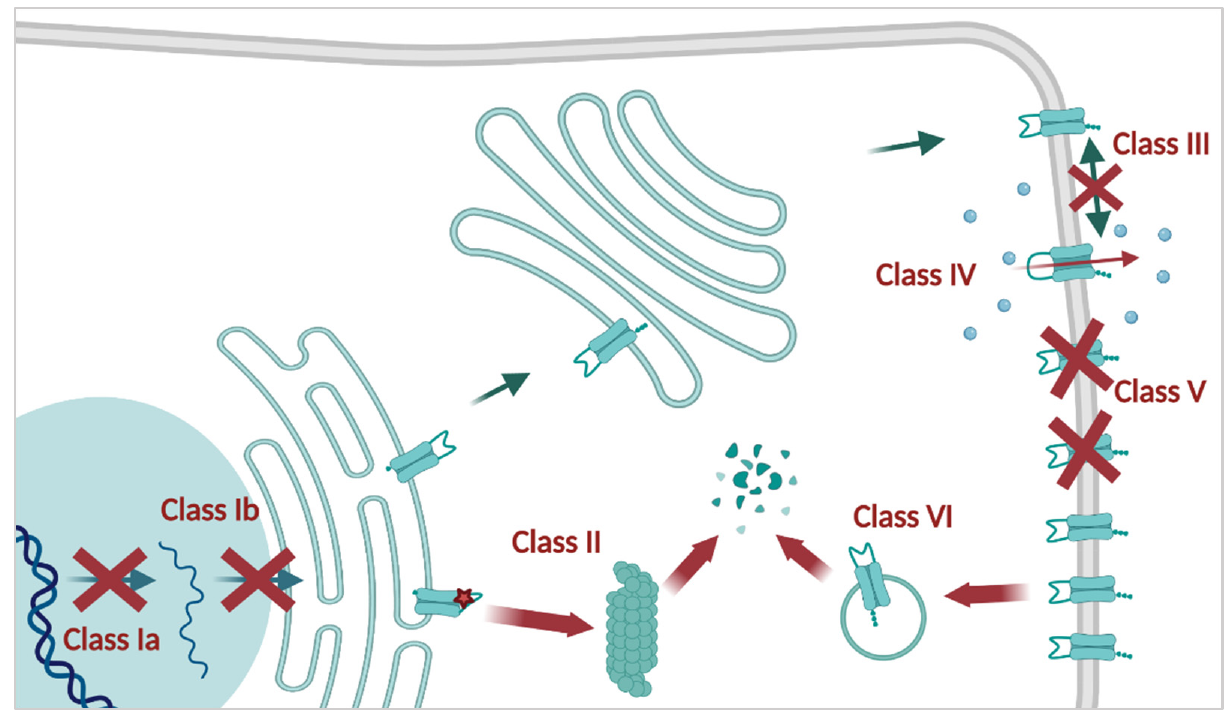
Figure 1. CFTR mutations can cause different defects and are grouped accordingly. Green arrows: normal CFTR biogenesis and function. Red arrows/crosses: defects caused by the mentioned mutation classes.